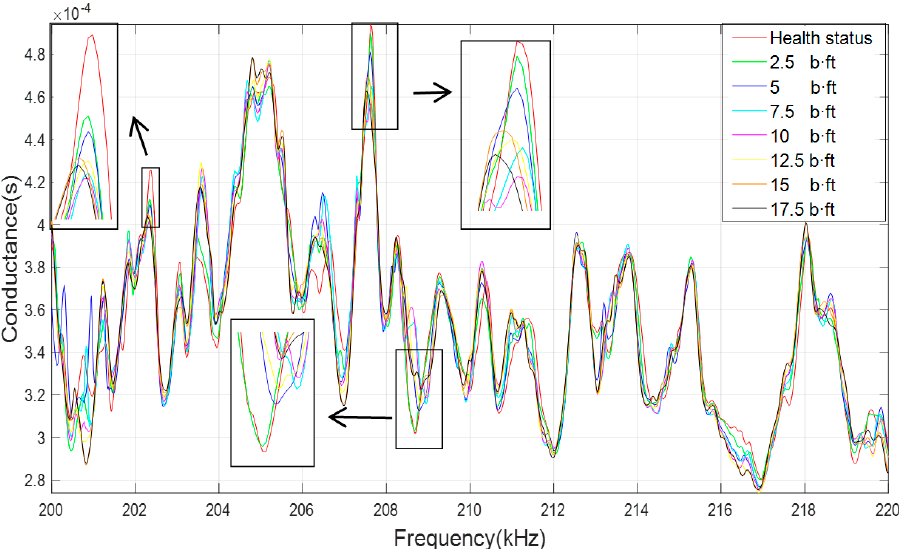
Figure 9. Conductance signatures at different torque level (200–220 kHz).